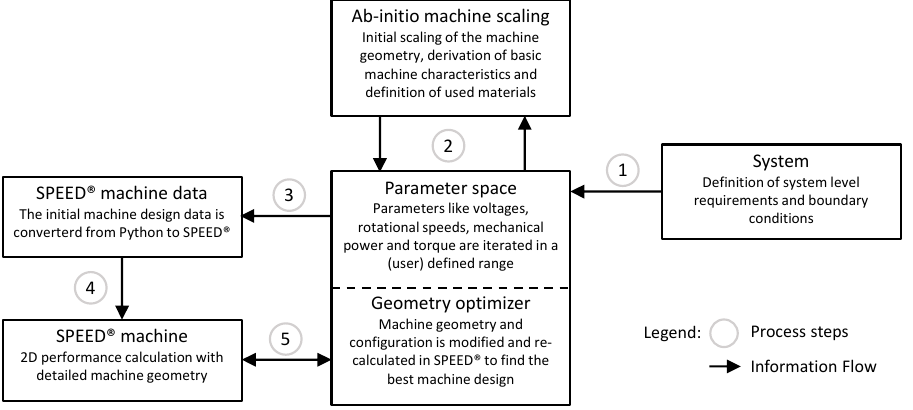
Figure 27. Basic electric machine design scheme.